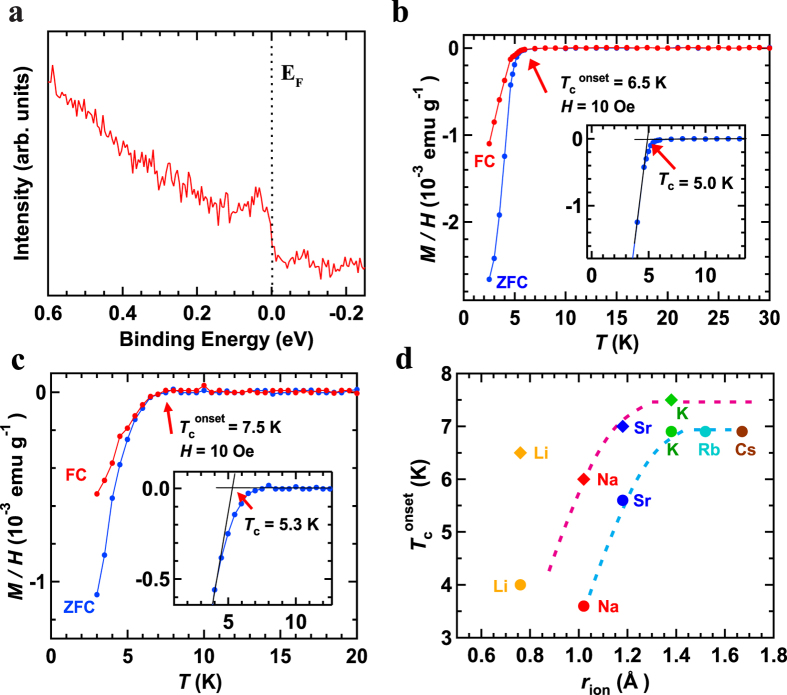
(a) Photoemission spectrum of (NH3)yNa0.5MoSe2. M/H versus T plots of (b) (NH3)yLi0.5MoSe2 and (c) (NH3)yK0.5MoSe2 agglomerations, respectively, in ZFC and FC modes (H = 10 Oe). (d) Plot of Tconset
vs. rion in (NH3)yMxMoSe2 and (NH3)yMxMoS2. Circles and diamonds refer to (NH3)yMxMoS2 and (NH3)yMxMoSe2, respectively. The plot is based on the data collected in this study (diamonds) and those in Refs 15 and 16 (circles).